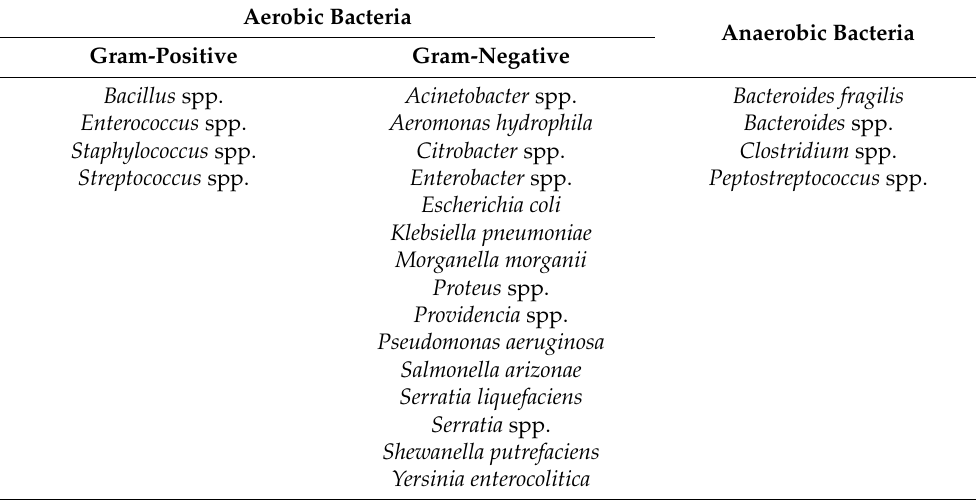
Table 1. Bacteria associated with secondary wound infection after snakebite and reported in the literature